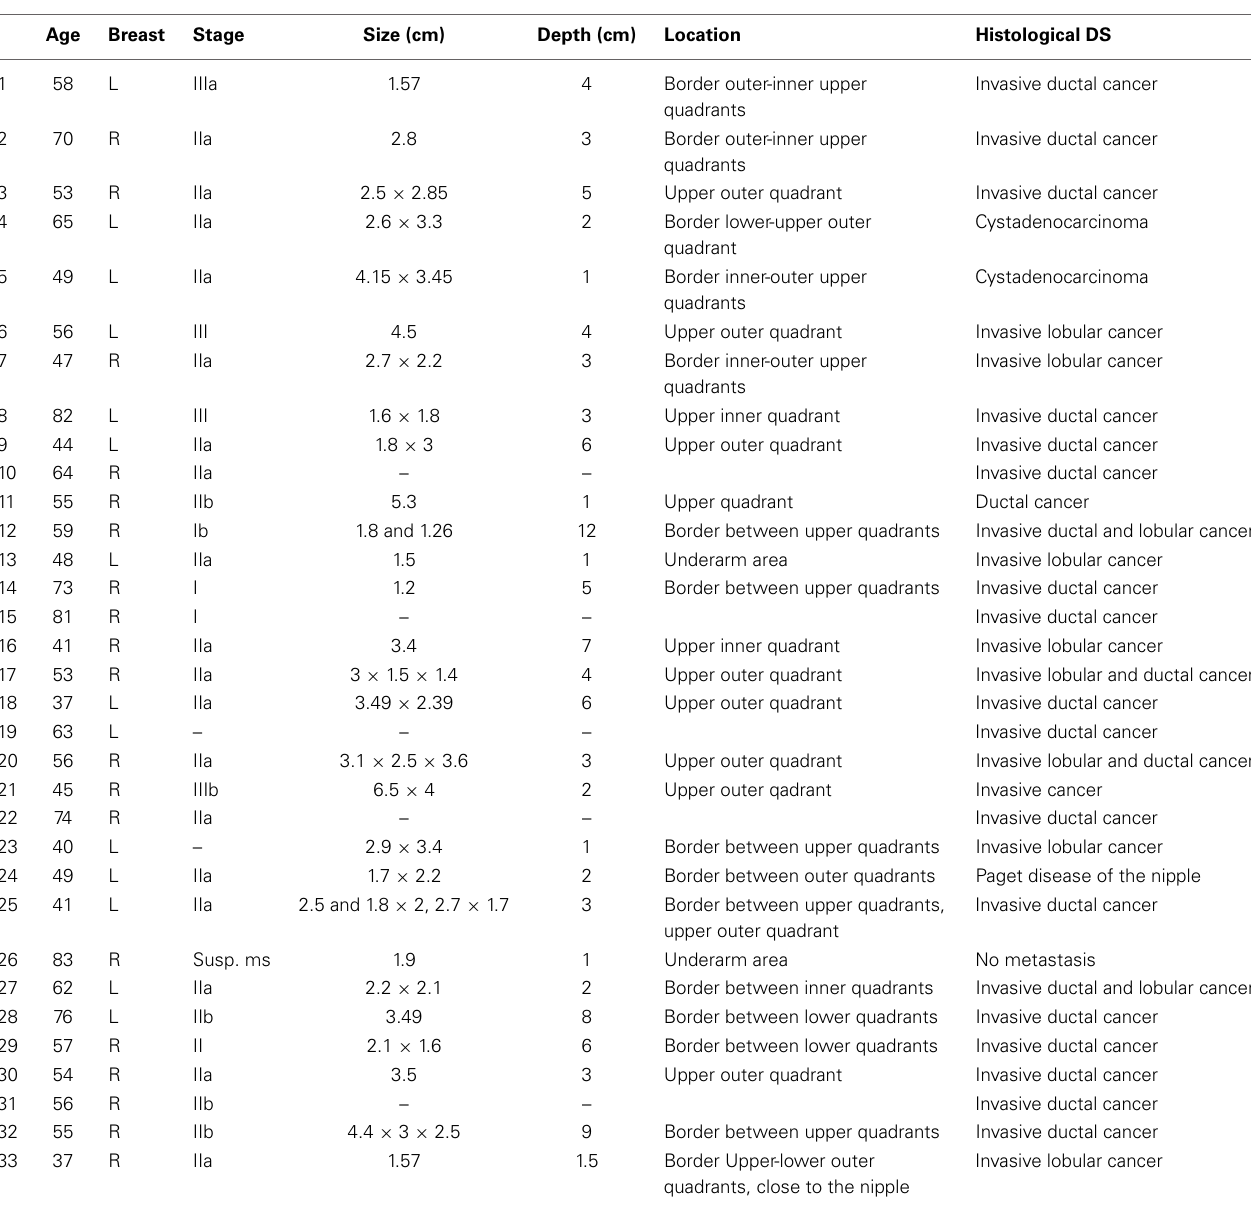
Table 1 | Set of (33) analyzed patients with age, cancerous breast (Right or Left), stage, size and depth of the malignant tumor and histology